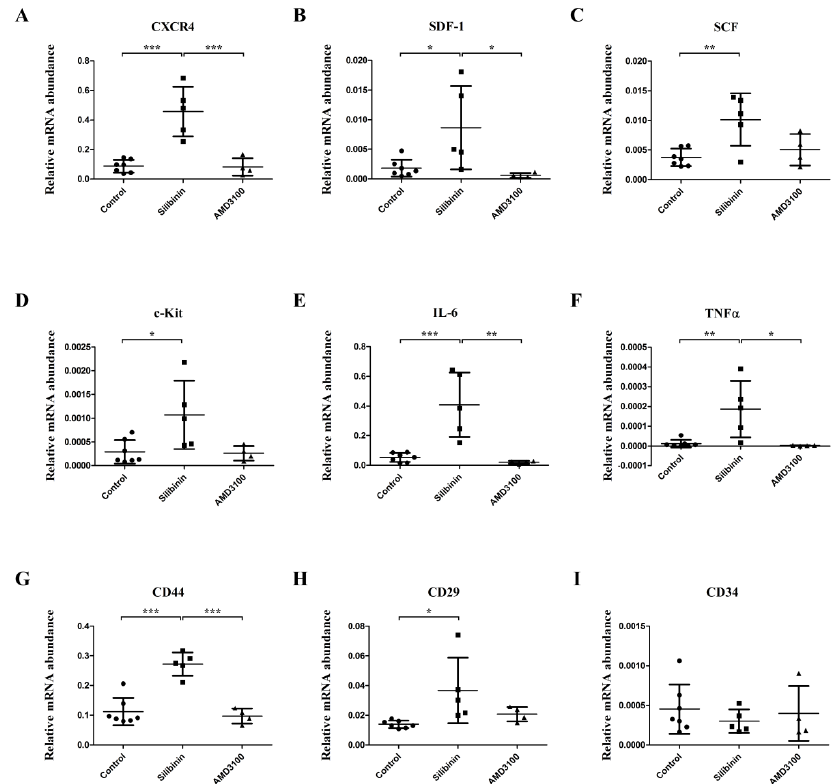
Figure 1. Comparison of gene expression levels of stem cell-related markers and inflammatory markers among control, silibinin, and AMD3100 treatment cultures from pulmonary arterial hypertension (PAH) rat bone marrow cells (BMCs). Silibinin significantly upregulated the expression of CXCR4 ( A ), SDF-1 ( B ), SCF ( C ), c-Kit ( D ), inflammatory markers IL-6 ( E ), TNFα ( F ), MSC-related markers CD44 ( G ), and CD29 ( H ). However, significant differences were not observed between the control group and AMD3100 group. Silibinin and AMD3100 did not upregulate the expression of HSC-related marker CD34 (I). * p < 0.05, ** p < 0.01, *** p < 0.001. Treatment groups consisted of seven samples in the control culture, five samples in the silibinin culture, and four samples in the AMD3100 culture.